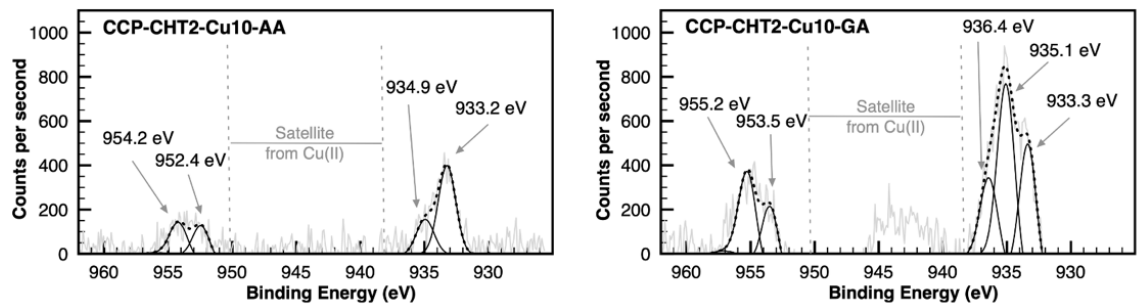
Figure 9. Gaussian deconvolution of high-resolution XPS Cu 2p spectra CCP-CHT2-Cu10-AA and CCP-CHT2-Cu10-GA samples. Table 3. Results of the XPS deconvolution analysis of the Cu 2p peaks for CCP-CHT2-Cu10-AA